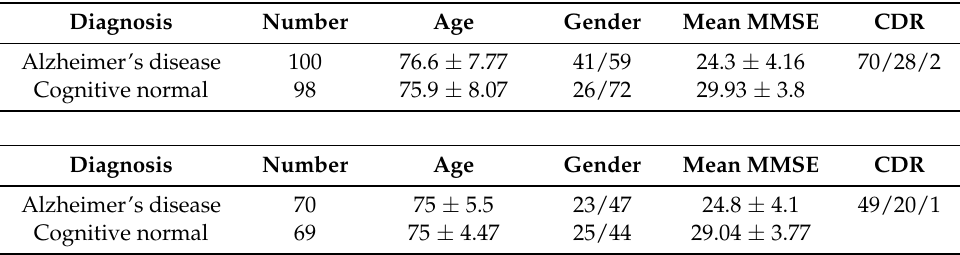
Table 2. Demographic information dataset on the subjects studied aged 60 and over ( upper table ) and for the reduced dataset ( lower table ). Gender is indicated as male/female, the Clinical Dementia Rating scale (CDR) values are indicated as the number or patients diagnosed as very mild dementia/mild dementia/moderate dementia. Age and Mini-Mental State Examination (MMSE) values are indicated as mean ± standard